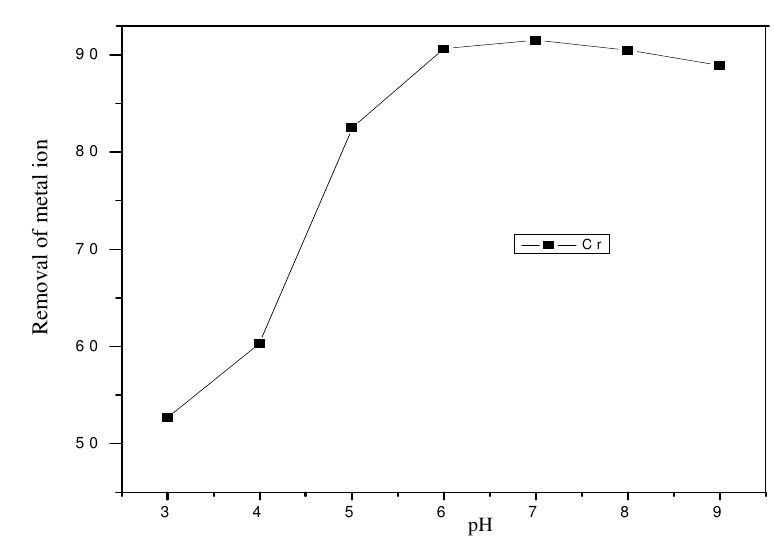
Figure 5. Effect of pH on the removal of chromium